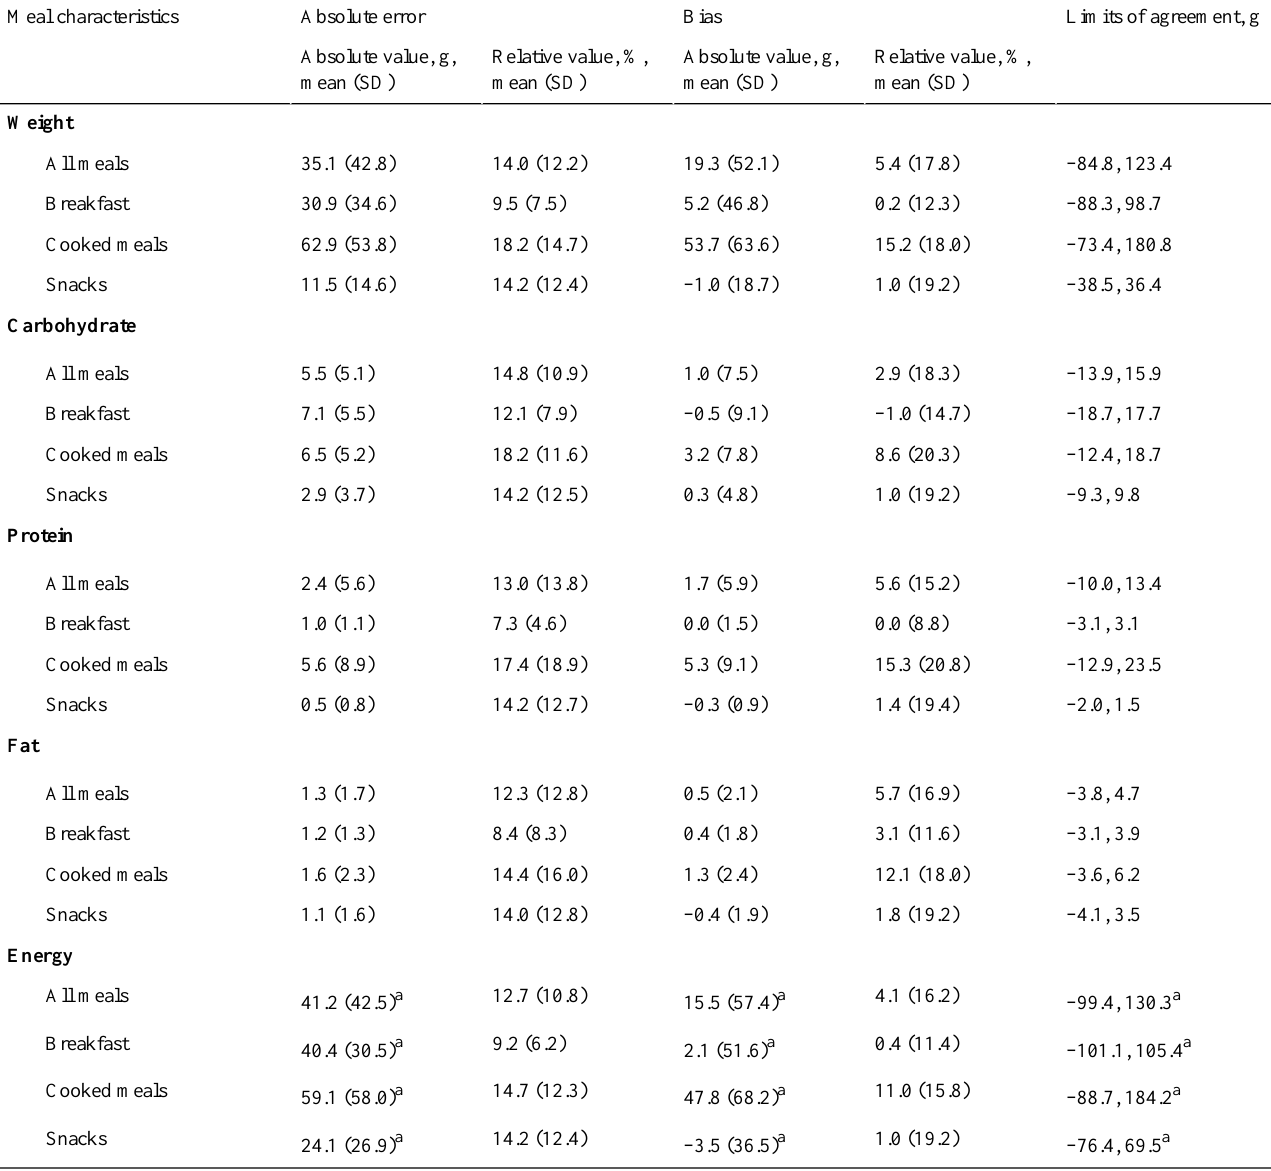
Table 1. Error metrics for all meals and by meal, reported as the difference between the app’s estimate and the reference weight, macronutrient content, or energy